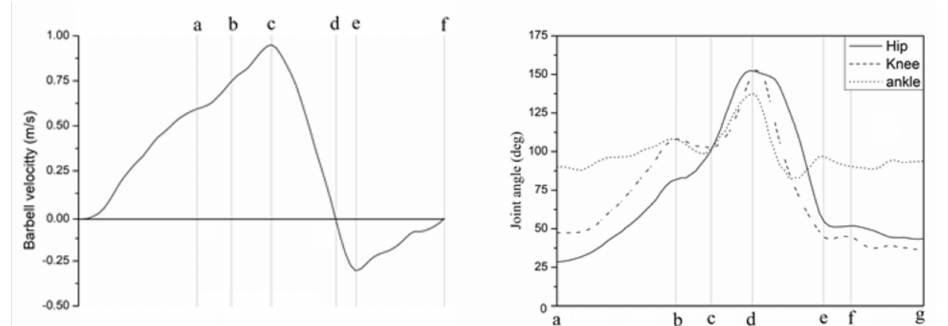
Figure 4. Changes of the velocity of the CGB and the lower-limb joint angle in a different phase (the left plot is the velocity of the CGB at different phases, the right plot is the description of the lower-limb joint angle at different